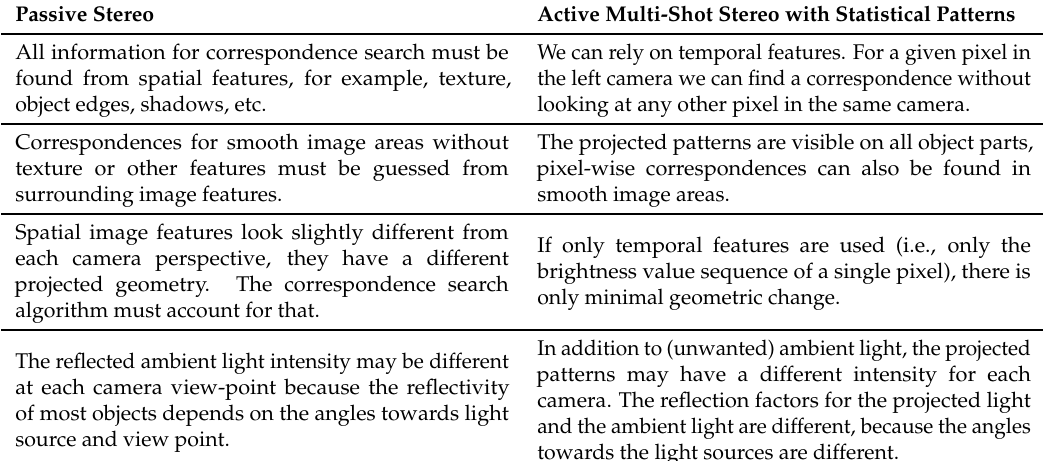
Table 1. Data processing challenges: differences between passive stereo and active multi-shot stereo with statistical